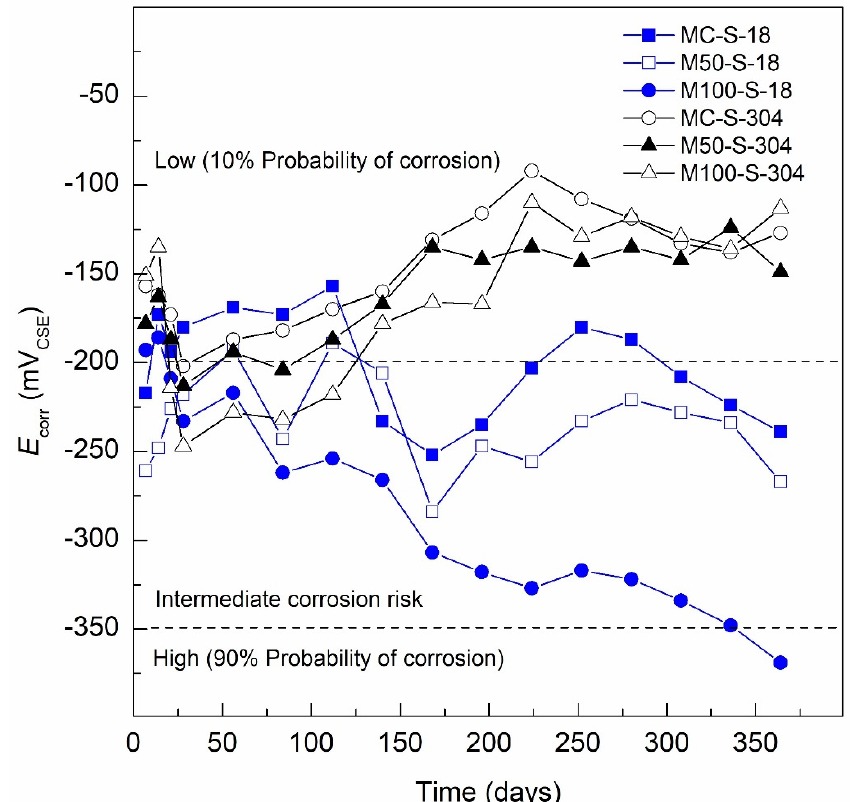
Figure 5. E corr specimens exposed 3.5 wt.% Na 2 SO 4 solution (aggressive medium).